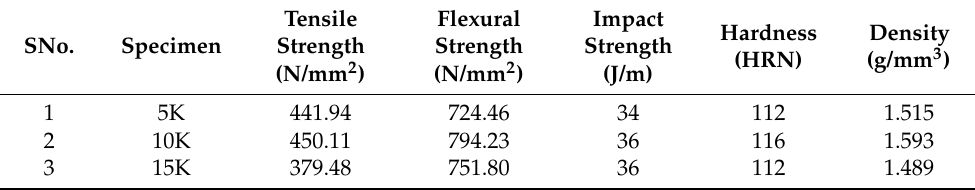
Table 3. Properties of the materials.